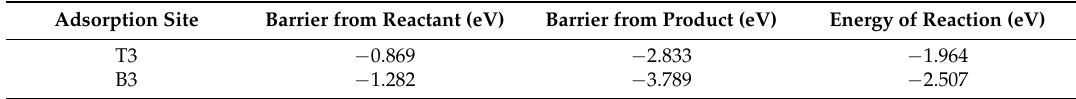
Table 4. Energy parameters of two types of chemical